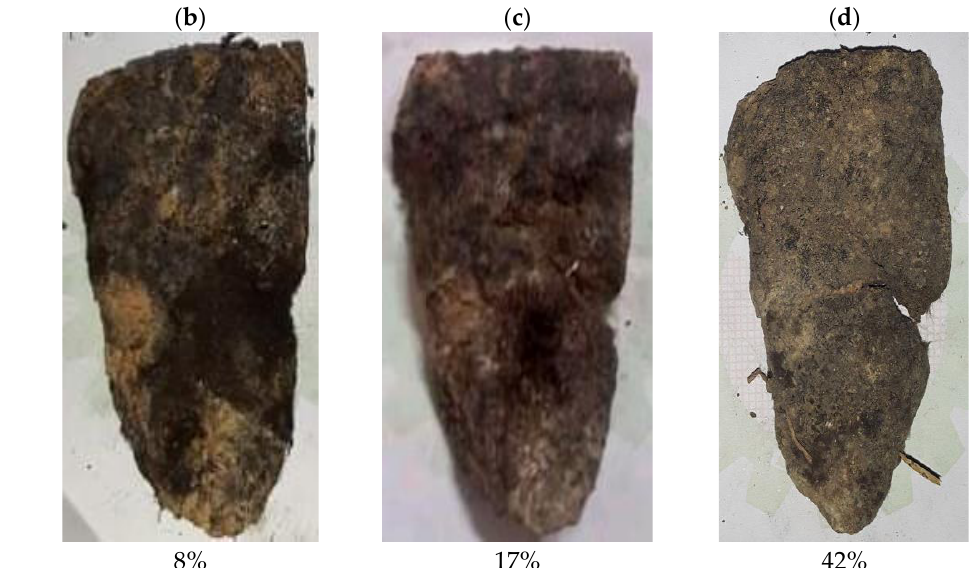
Figure 5. 15% fenugreek containing bio-composite degradation sample on ( a ) Day 1, ( b ) Day 7, ( c ) Day 15, and ( d ) Day 30.